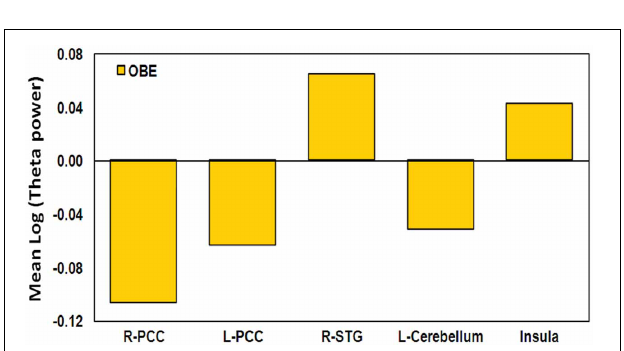
FIGURE 8 | OBE participant activity in the ROIs. Mean log theta power during the Timelessness and Spacelessness conditions, in the selected